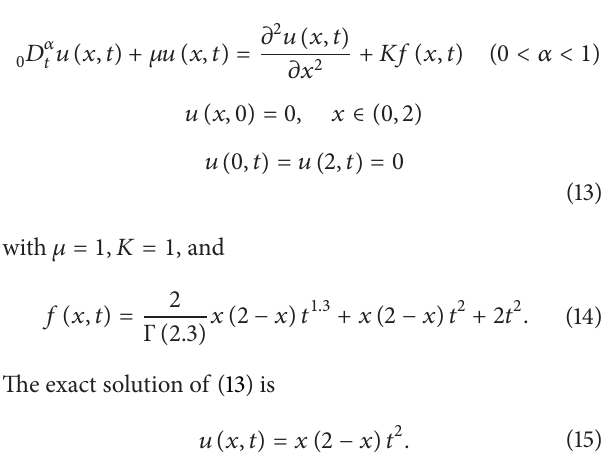
Figure 1: Comparison of exact solution to the parallel GPU solution at 𝑇 = 0.3, 0.5, 0.7 .